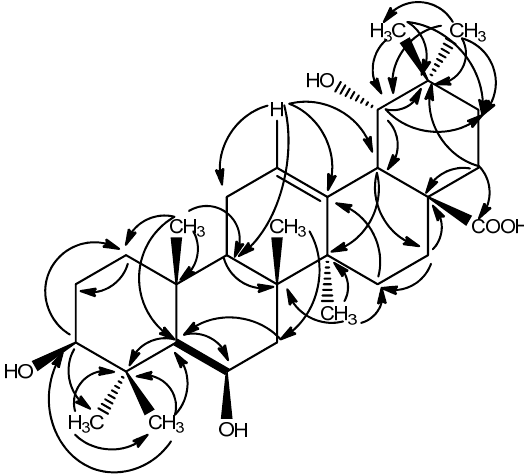
Figure 2. Selected HMBC ( 2 J and 3 J ) correlations (H → C) and H-H COSY correlations of compound 1 .